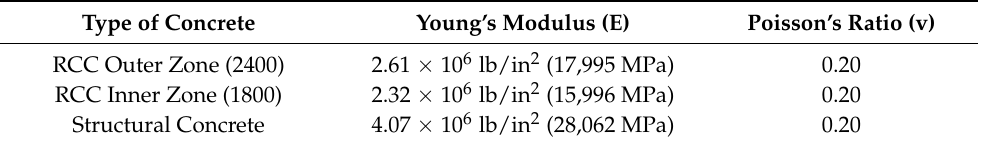
Table 4. Modulus of elasticity and Poisson’s ratio for the monoliths.